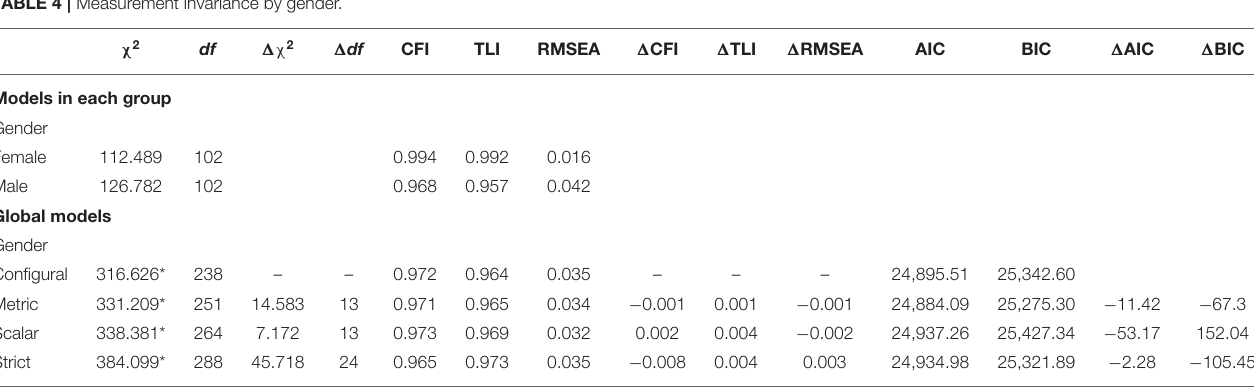
TABLE 4 | Measurement invariance by